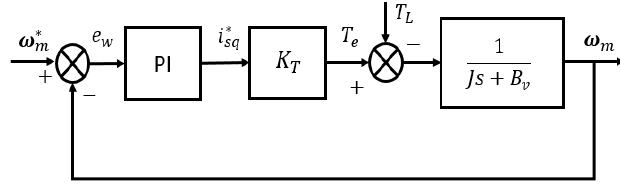
Figure 2. Simplified block diagram of the IM speed regulation.